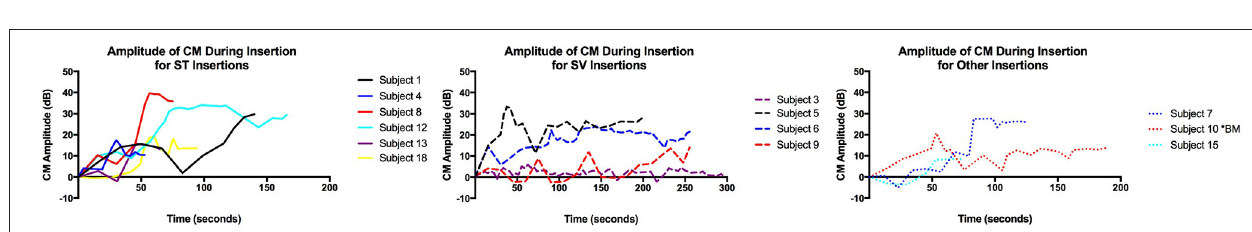
FIGURE 6 | Change in cochlear microphonic (CM) amplitude, in dB re: microVolts, during insertion is shown according to scalar location of the electrode array.